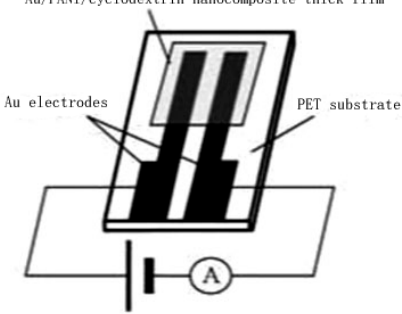
Figure 2 . The schematic diagram of the structure of Au electrodes on a flexible polymer substrate.